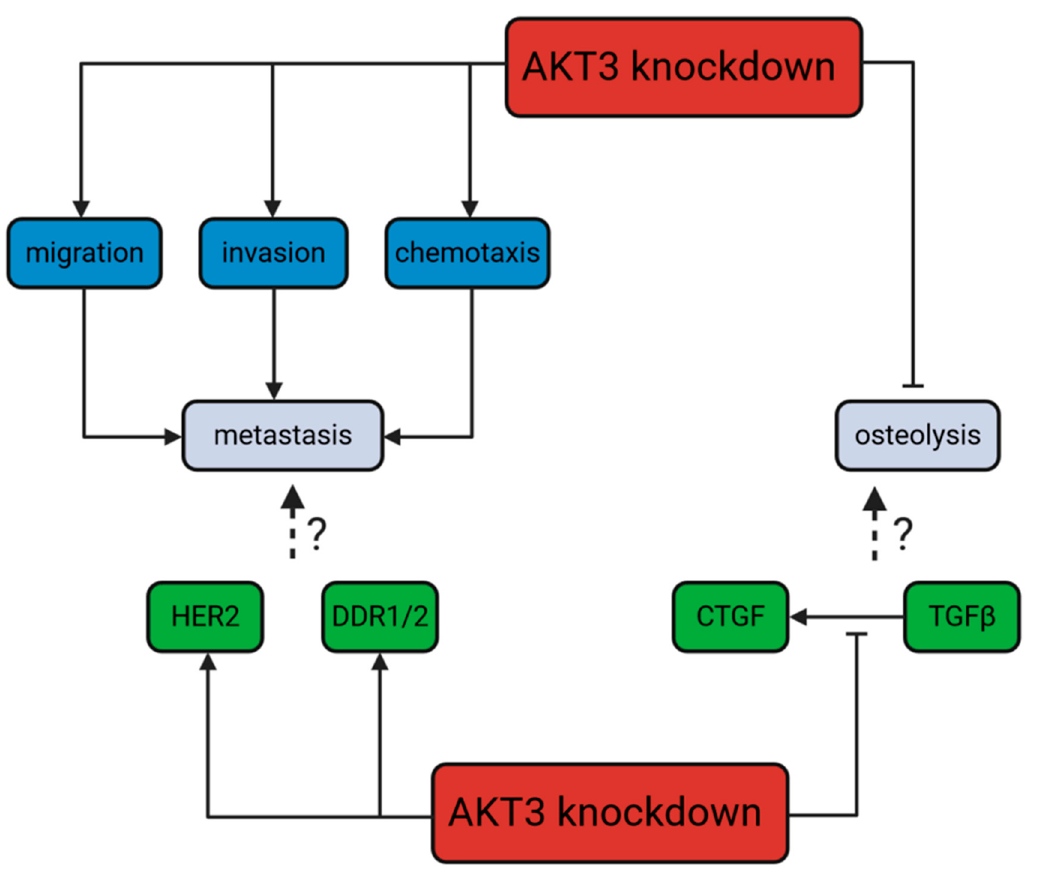
Figure 10. Dichotomic role of an AKT3 knockdown in 231-BO cells: promotion of metastasis but not osteolysis: On the one hand, knockdown of AKT3 increases, among others, DDR1/2 and HER2 signaling in bone-seeking breast cancer cells as well as promoting migration, invasion, and chemotaxis as steps of the metastatic process in general. HER2 and DDR1/2 activity is associated with metastasis in breast cancer in the literature. On the other hand, knockdown of AKT3 decreases the TGF β -stimulated CTGF expression. In connection to these findings, knockdown of AKT3 leads to an absent promotion of osteolysis. The TGF β /CTGF axis is correlated with the vicious cycle of osteolysis in breast cancer in the literature.